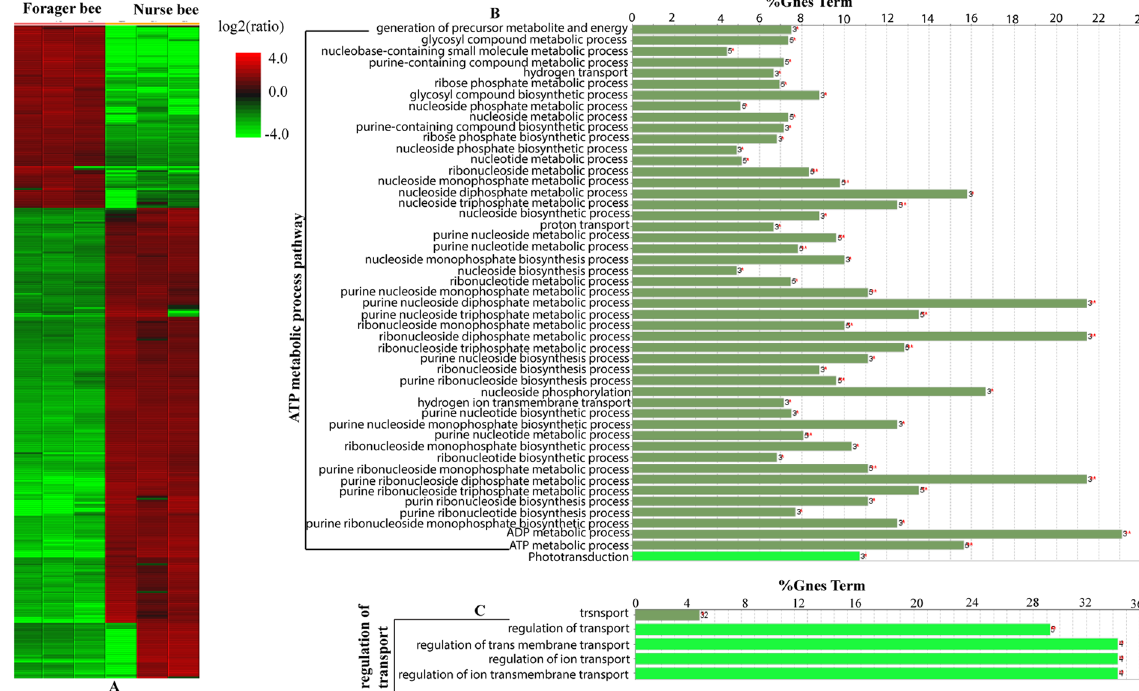
Figure 6. Quantitative proteome comparison during the development of bee brain (fold change ≥ 2 and p < 0. 05). ( A ) Hierarchical clustering of the differentially expressed proteins (fold change > 2 and P < 0.05); the columns represent the replicates in each of the nurse and forager bees, and the rows represent the individual proteins. The up- and down-regulated proteins are distinguished by red and green color, respectively. The color intensity changes with the protein expressional level as indicated on the bar. ( B and C ), Enriched functional groups and pathways of up-regulated proteins in the nurse and foraging bee brain respectively.